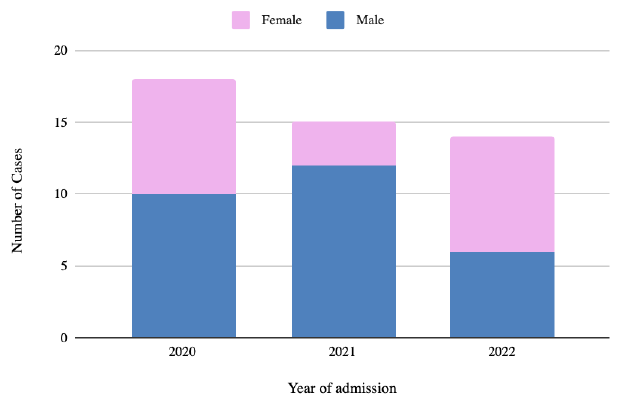
Figure 1. Number of pediatric burn patients needing hospital admission, divided by year. General demographics are shown in Table 1. Table 1. Features of pediatric burn patients who presented to our Emergency Unit from 1